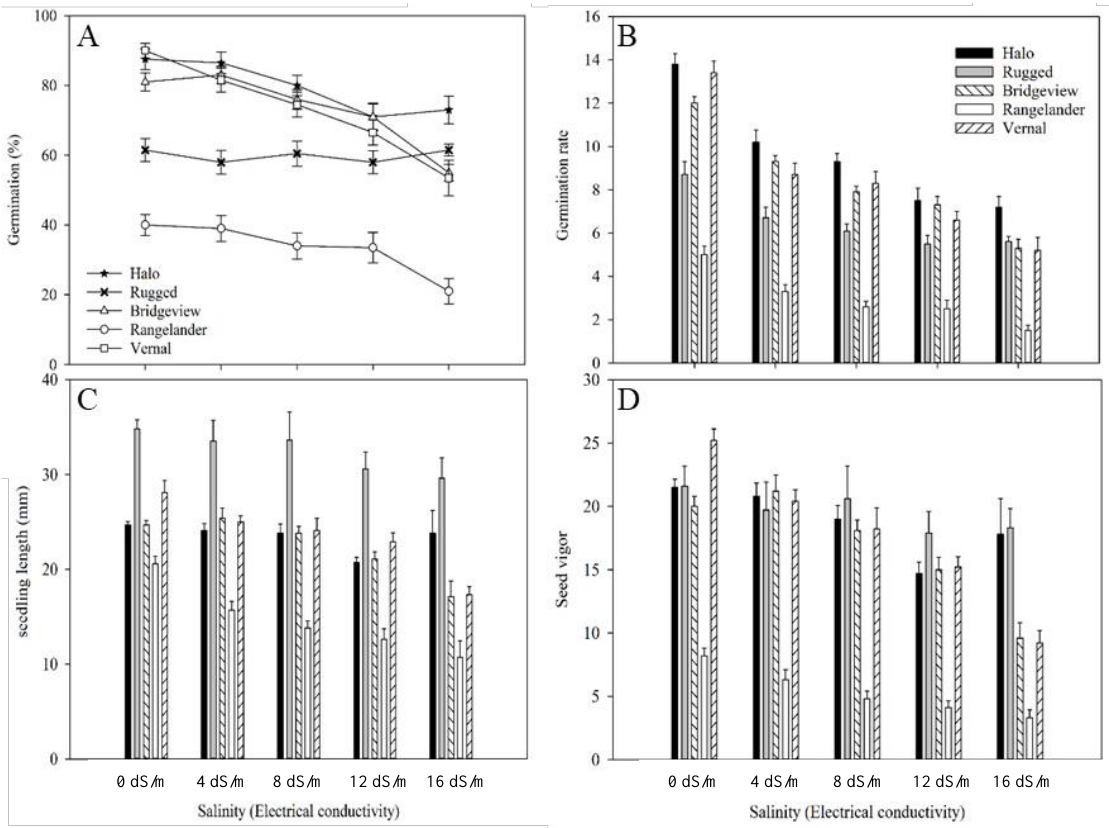
Figure 1. ( A ) Cumulated seed germination (%), ( B ) germination rate, ( C ) seedling length (mm) and ( D ) seed vigor of five alfalfa cultivars under five gradients of salinity: 0 dS m −1 , 4 dS m −1 , 8 dS m −1 , 12 dS m −1 , 16 dS m −1 (error bar represents standard errors of means).